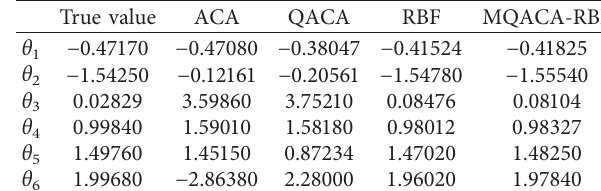
Table 2: Comparison of inverse solutions of the ZrARM robotic arm point A and point B ( ° ): A-point inverse solution result comparison.